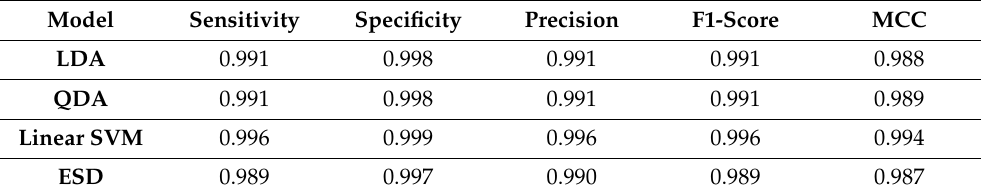
Figure 5. Confusion matrices obtained as a result of classification of PCA-based incorporated CNN features with machine learning algorithms.